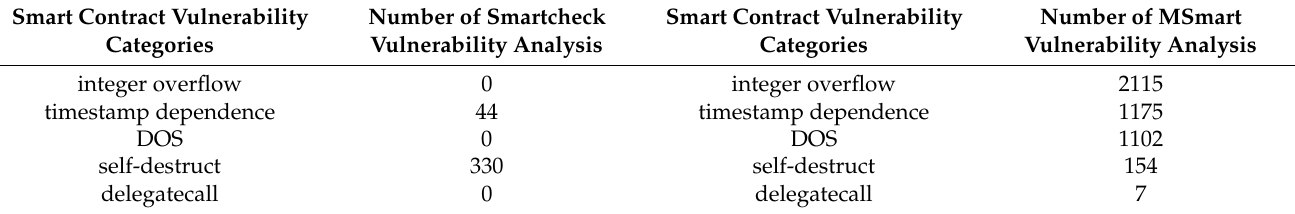
Table 2. Comparison of MSmart and Smartcheck on large data